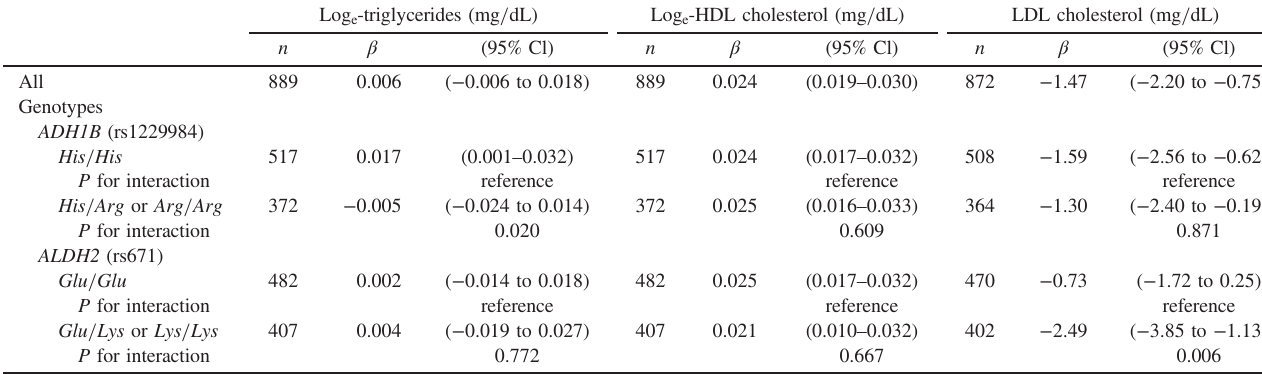
Table 3. Increase in serum lipid levels with an increase of alcohol intake by 10g / day according to the genotypes of ADH1B and ALDH2